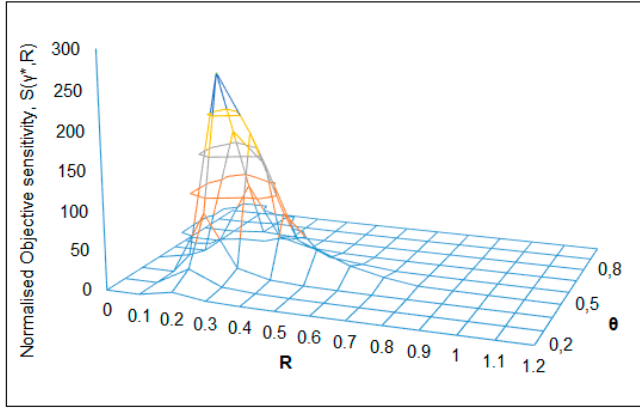
Figure 8. Normalized objective sensitivity S( γ *, R) as a function of parameters R and θ .